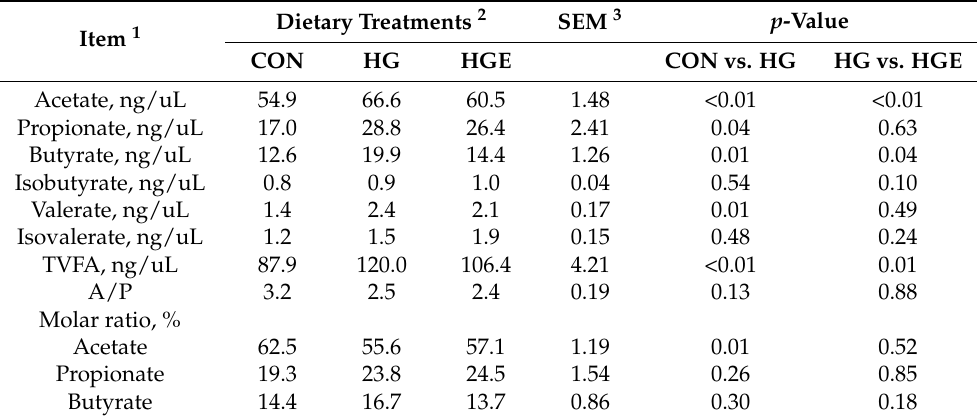
Table 5. Effects of vitamin E on volatile fatty acids in rumen induced by high concentration in subacute ruminal acidosis